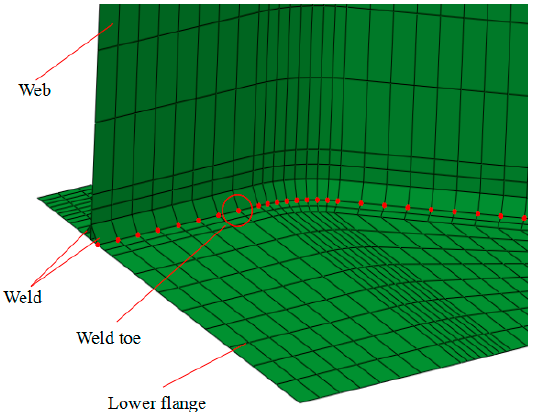
Figure 5. Finite element analysis (FEA) modeling scheme of the equivalent structural stress (ESS) method.